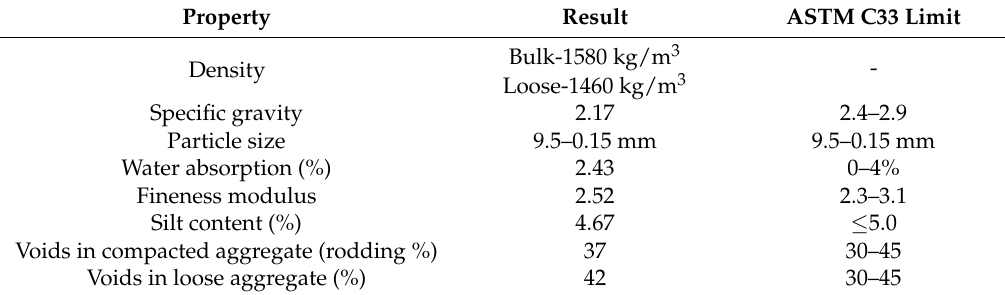
Table 4. Properties of fine